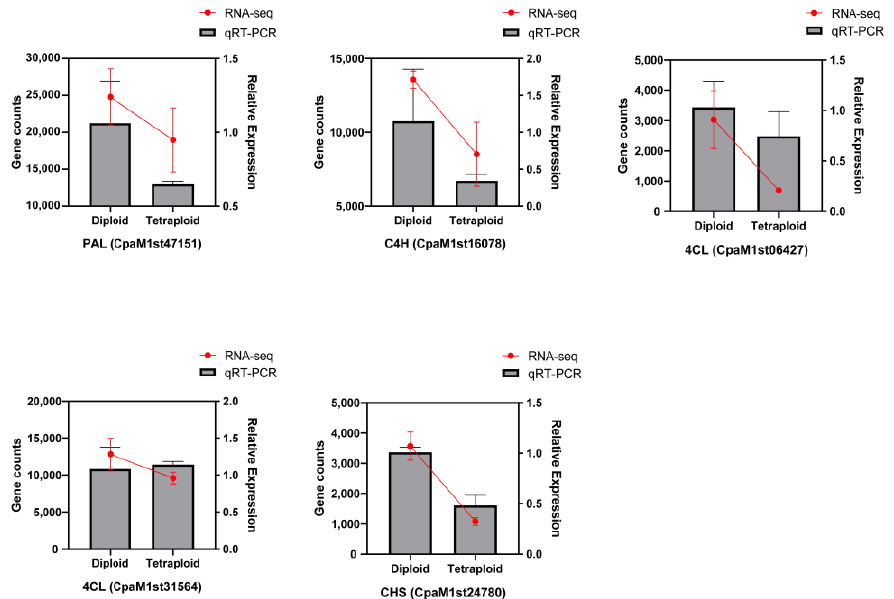
Figure 5. RT-qPCR detection of candidate genes related to flavonoid biosynthesis in C. paliurus . RT-qPCR shows the relative gene expression in September, obtained via RT-qPCR. The RNA-seq shows gene read counts obtained from the transcriptome data.